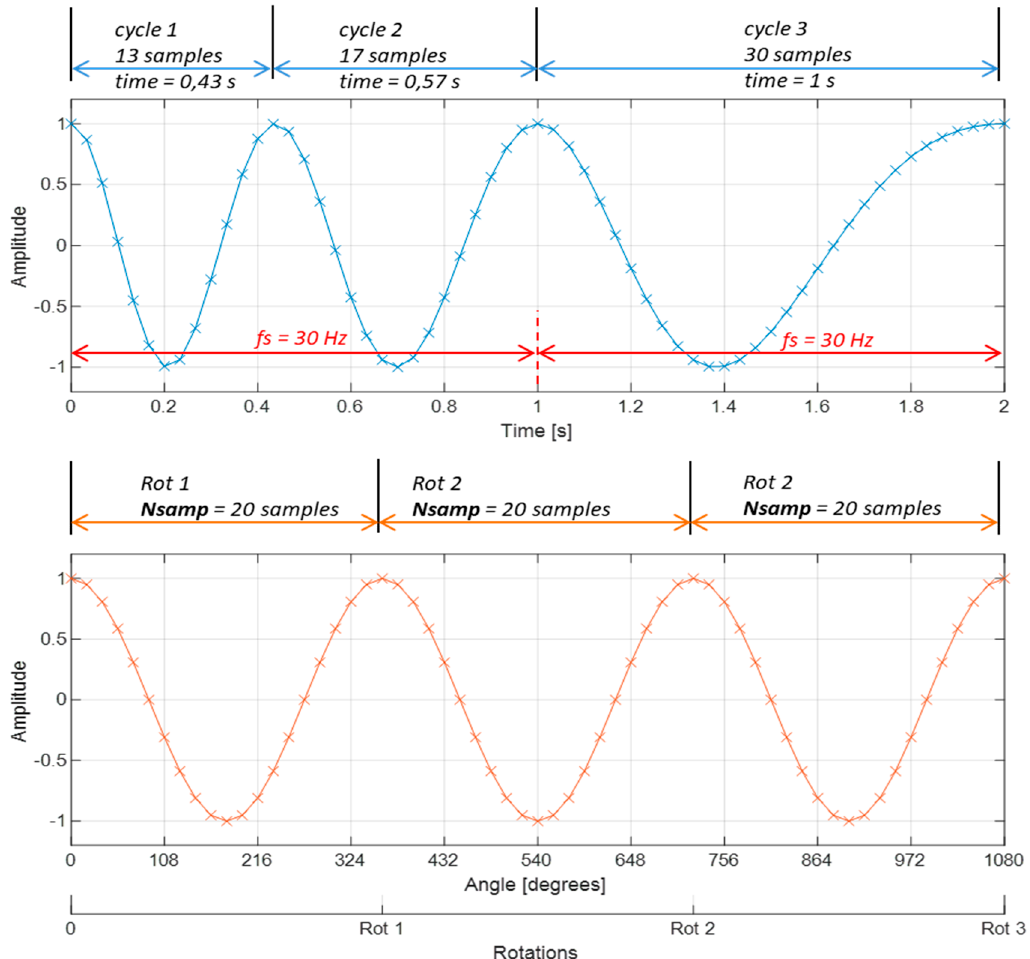
Figure 4. Top: signal sampled with constant sampling frequency, bottom: signal sampled with a constant number of samples per rotation.